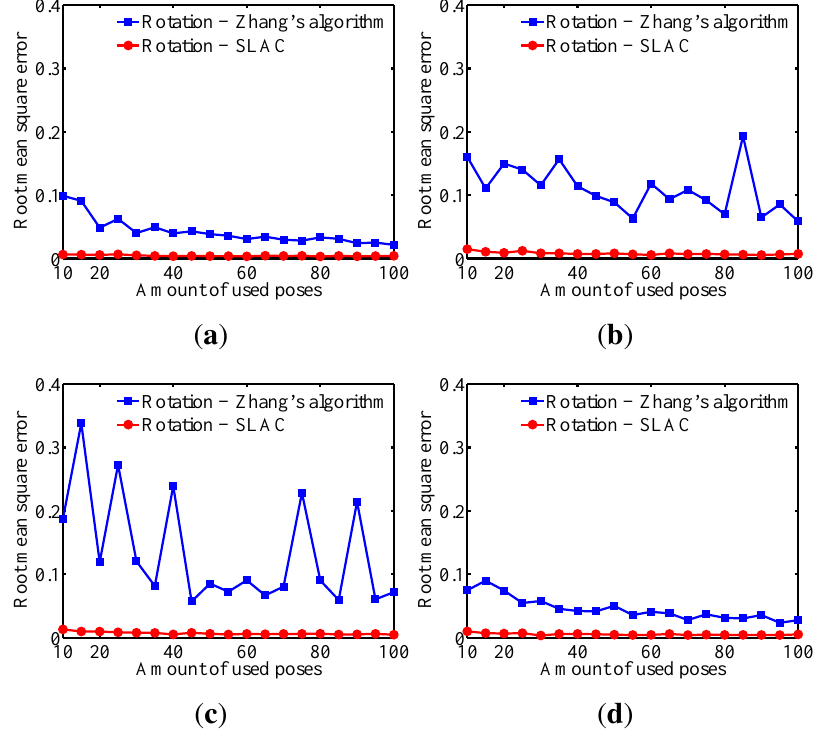
Figure 14. Simulation results for the rotation parameters for different amounts of used